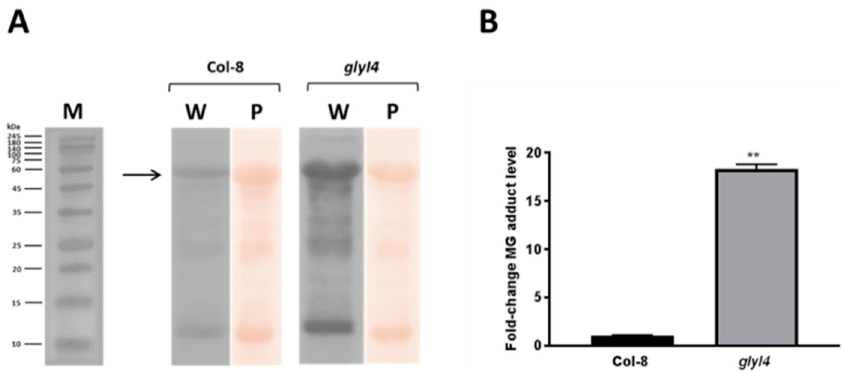
Figure 3. MG-protein adducts level in Arabidopsis Col-8 and glyI4 leaves. ( A ) Western blot performed with anti-methylglyoxal monoclonal antibody using Col-8 and glyI4 total protein extracts (40 g) from five-week-old plant leaves (W). Ponceau S staining (P) was used to normalize protein loading. Protein molecular weight markers are also shown (M). ( B ) Densitometric analysis of the most intense MG protein-adduct band, as indicated by the arrow in A. Fold-change is relative to the expression in Col-8 plants and normalized to the Ponceau stained band. Shown data are means of three biological replicates. Error bars represent SEM. Asterisks indicate the statistically significant difference between Col-8 and glyI4 (t-test; ** p < 0.005).